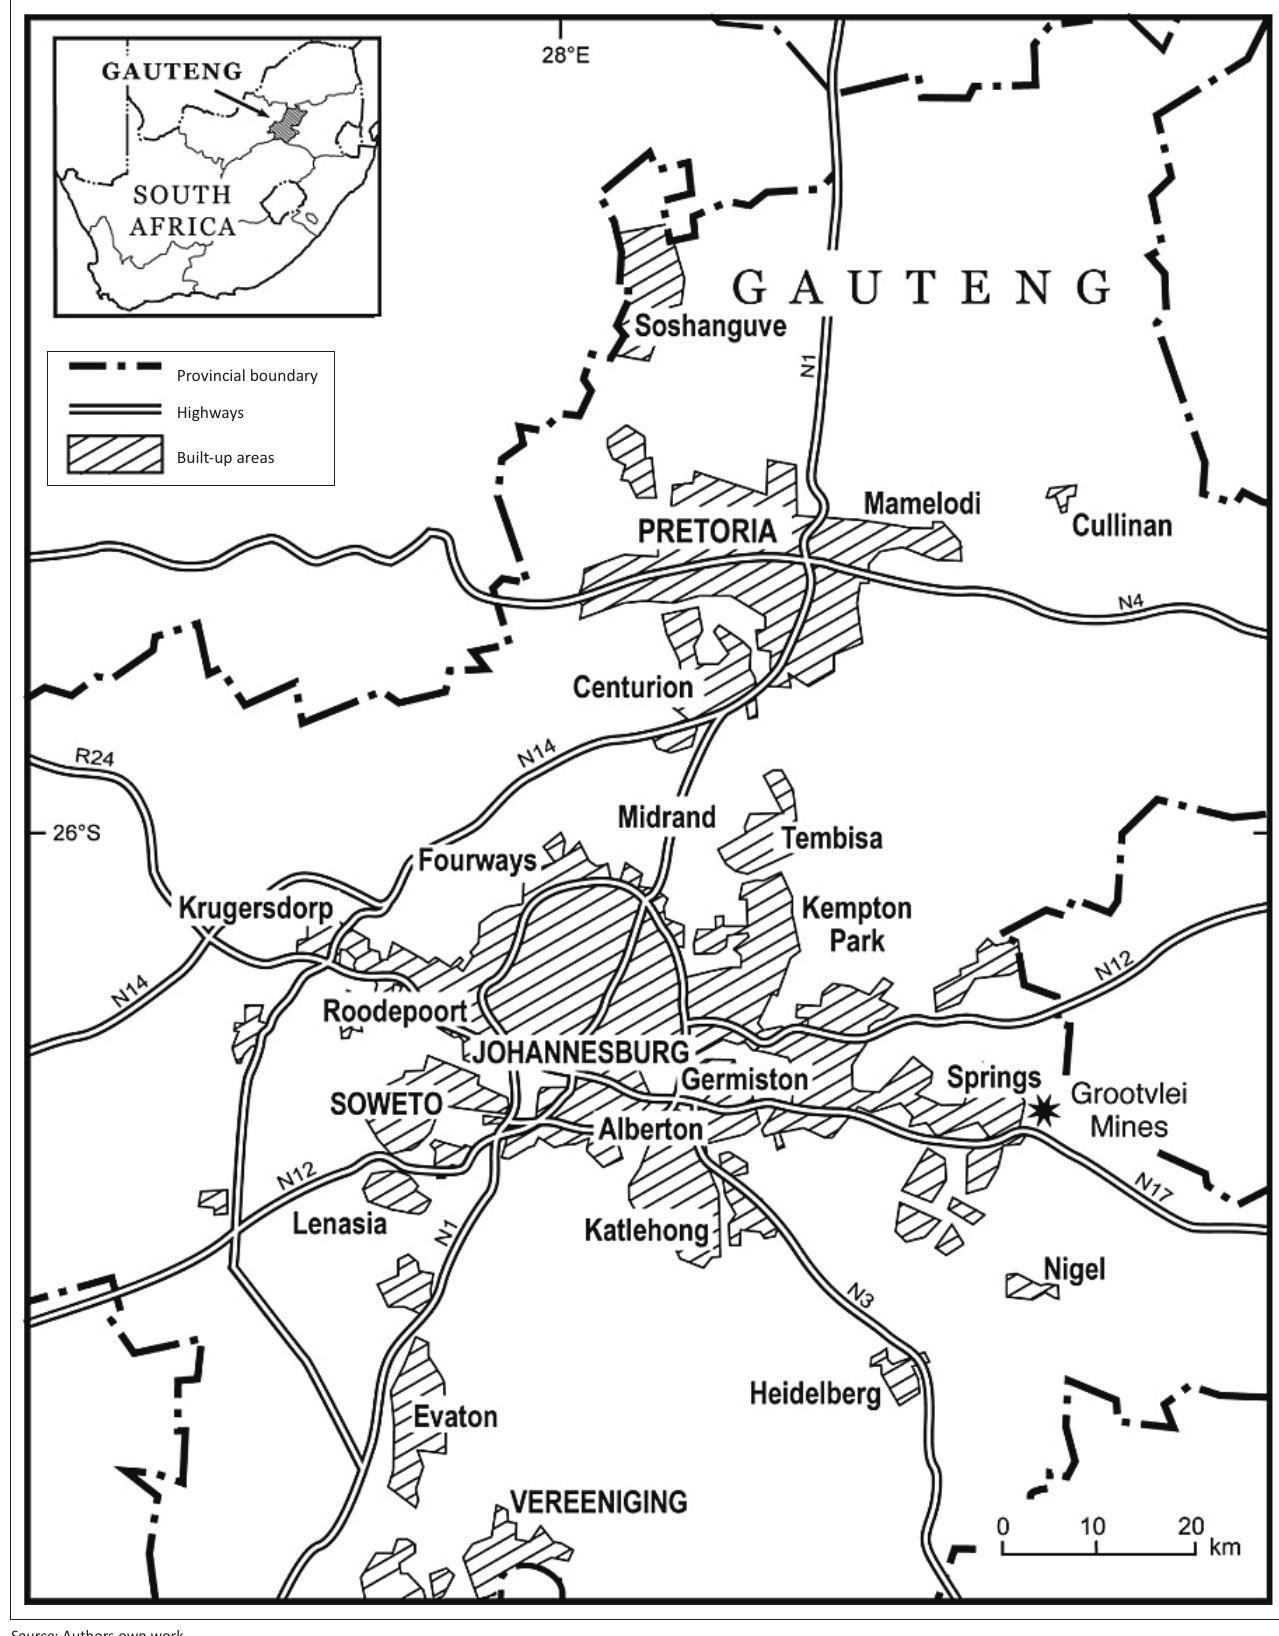
FIGURE 1: Grootvlei Gold Mine, Gauteng, South